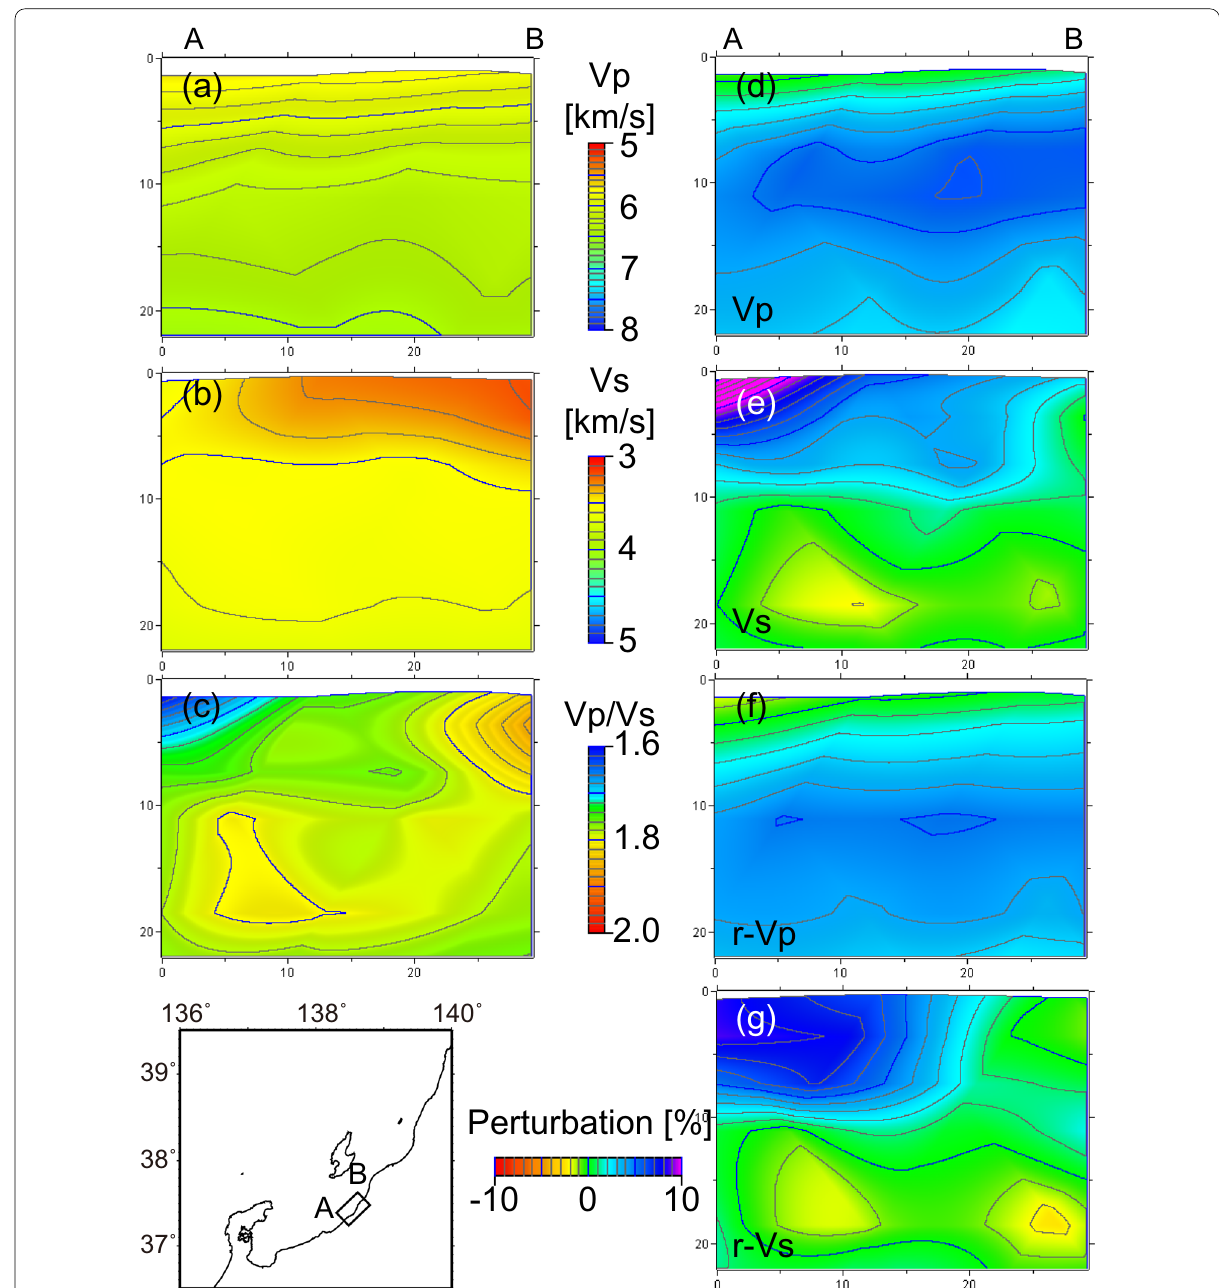
Fig. 22 Seismic velocity structure and restored resolution test along the coseismic slip region of the 2007 offshore Chuetsu